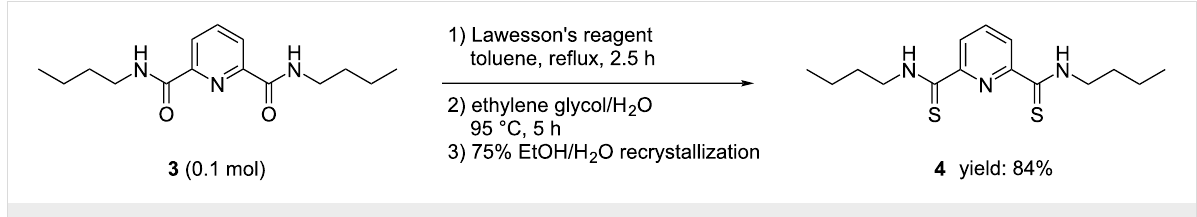
Scheme 1: Modified process for the synthesis of pincer ligand 4